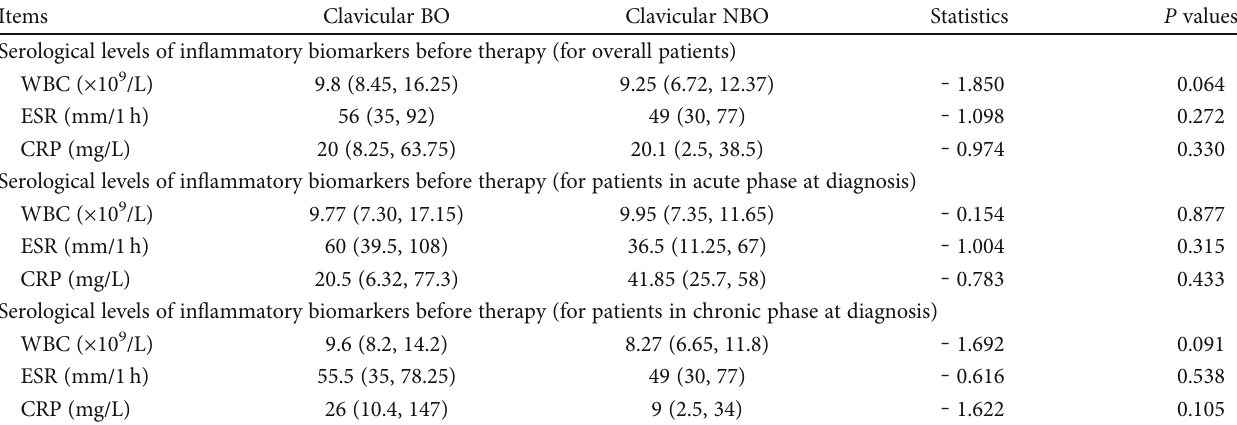
Table 2: Serological levels of WBC, ESR, and CRP for di ff erential diagnosis of clavicular BO and NBO.